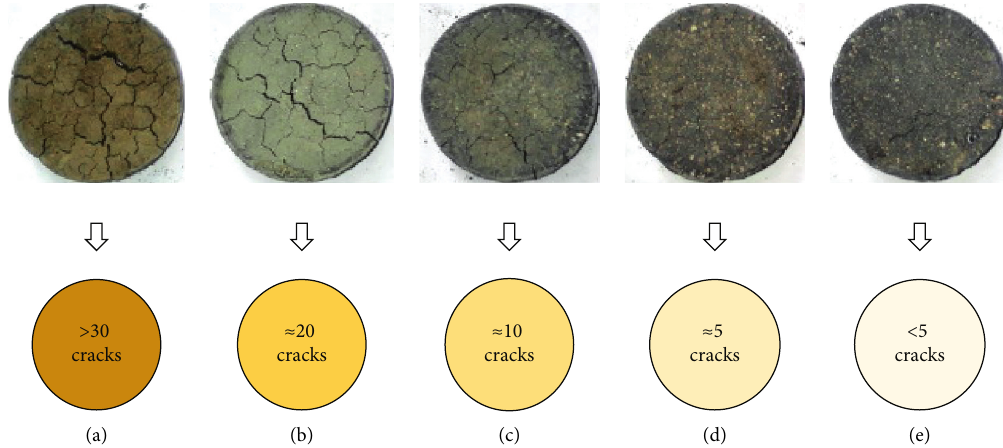
Figure 4: Morphology of cracks in expansive soil (LL � 77.6%, PI � 40.7%, MDD � 1.47g/cm 3 , and OMC � 28%) after blending with several mixtures of calcium carbide residue (CCR) and rice husk (RHA) and cured for 28 days